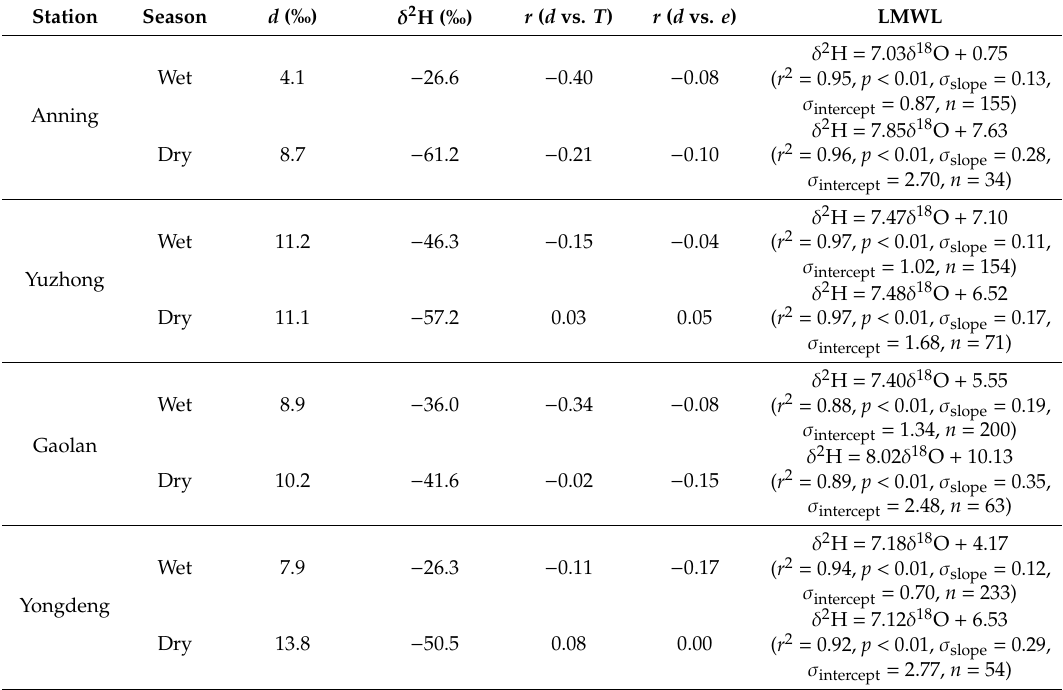
Table 3. Comparisons of mean d value, δ 2 H, correlation coefficients ( r ) between d value and air temperature ( T ) or water vapor pressure ( e ), and the local meteoric water lines (LMWLs) during the